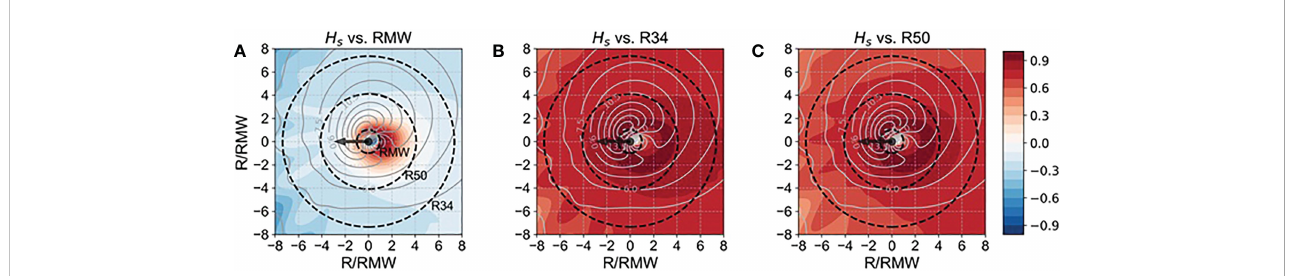
FIGURE 5 Spatial distribution of the correlation coef fi cients (shading) between signi fi cant wave height and TC size parameters ( A , RMW; B , R34; C , R50) at all grid points. These results were obtained from 105 North Atlantic hurricanes with MWS of 105 knots and V fm of 5.25 m s -1 . Arrows indicate the direction of propagation of the storm. Dashed lines indicate RMW, R50, and R34. Gray contours represent the composite (average) of all the signi fi cant wave heights (unit: m) for the 105 TCs. All values are expressed on axes normalized in RMW.